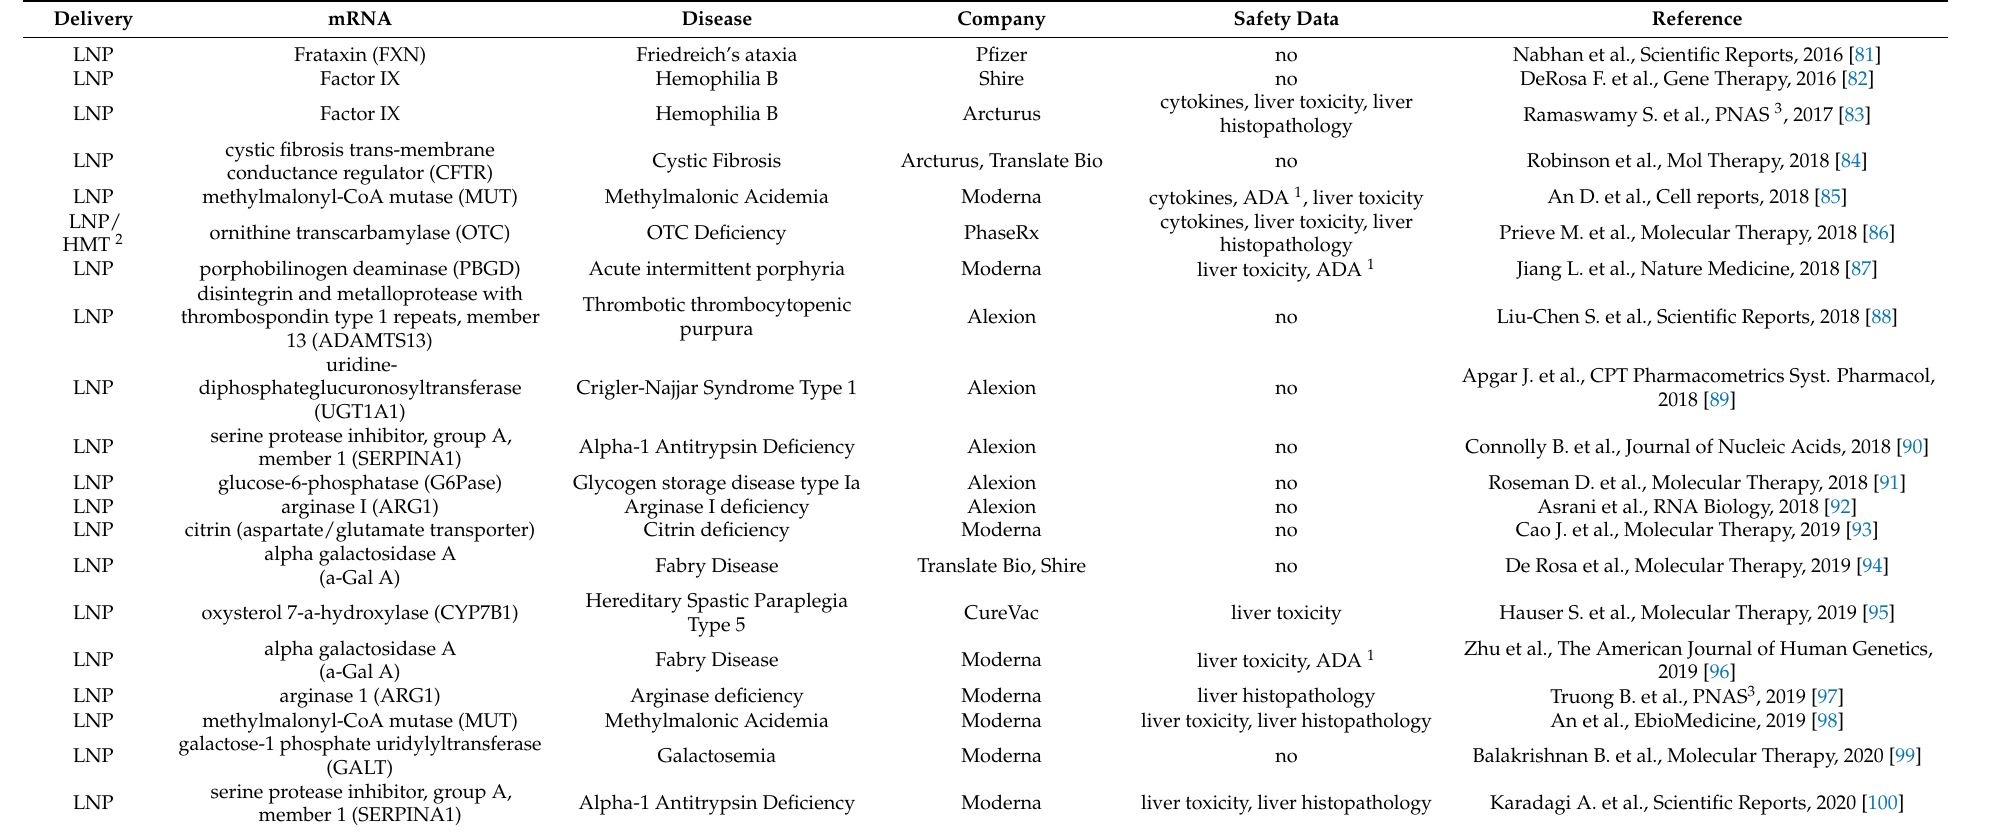
Table 1. Overview of current LNP-mRNA-based protein replacement and rare disease preclinical